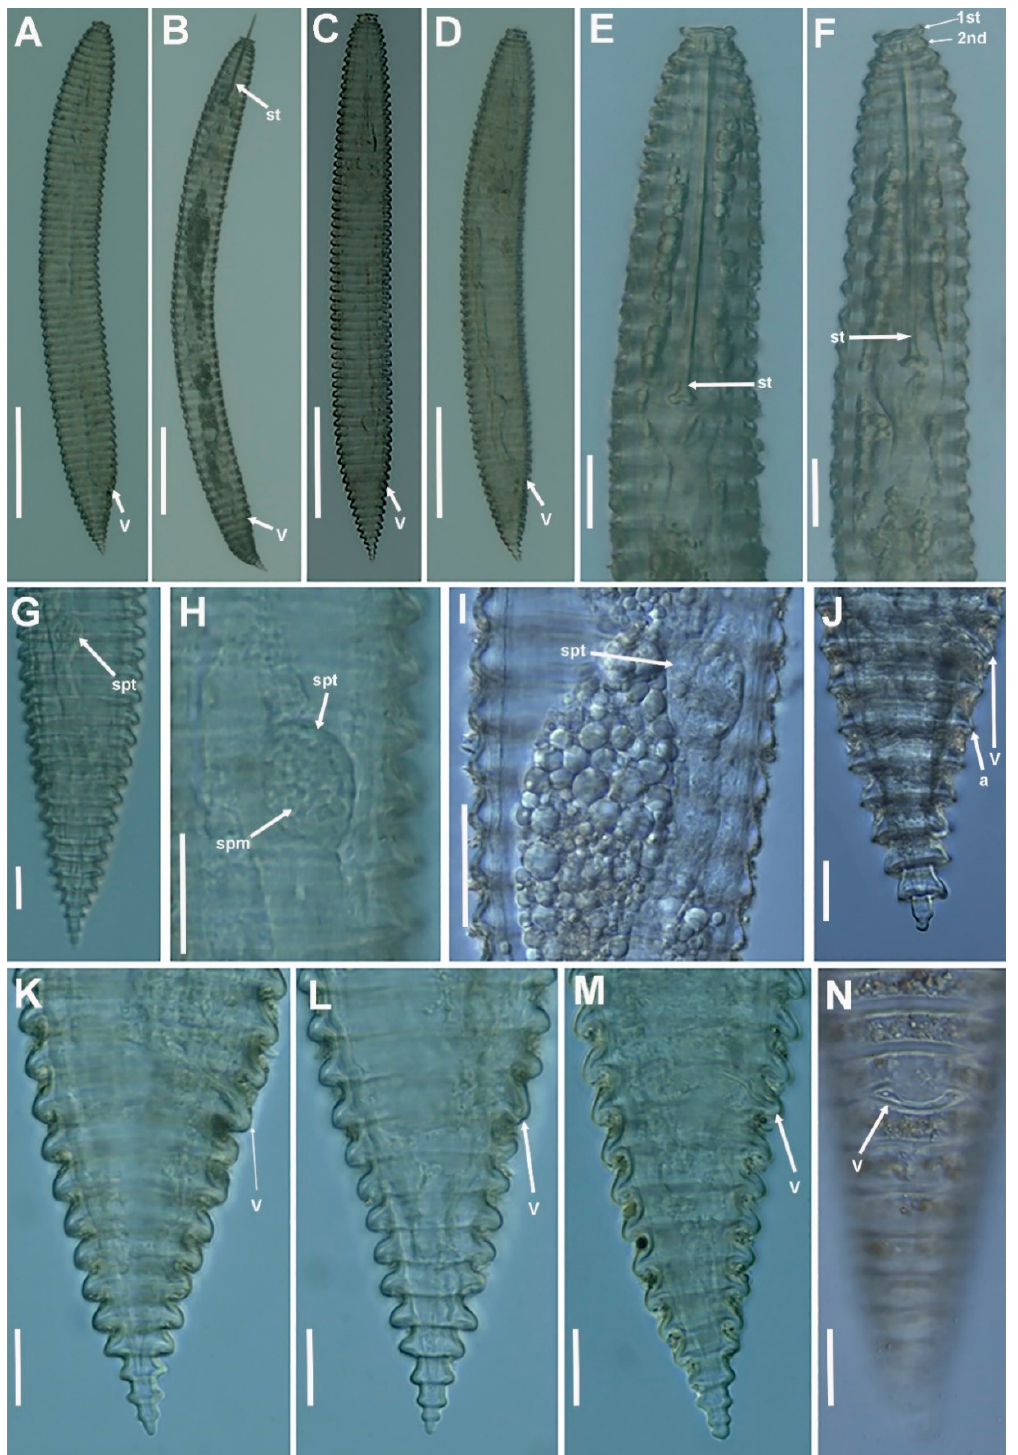
Figure 7. Line drawings of Criconema plesioannuliferum sp. nov. ( A ), female pharyngeal region; ( B ), detail of female lip region; ( C ), detail of spermatheca; ( D , E ), female posterior region; ( F ), male ante- rior region showing absence of stylet; ( G ), male posterior region.